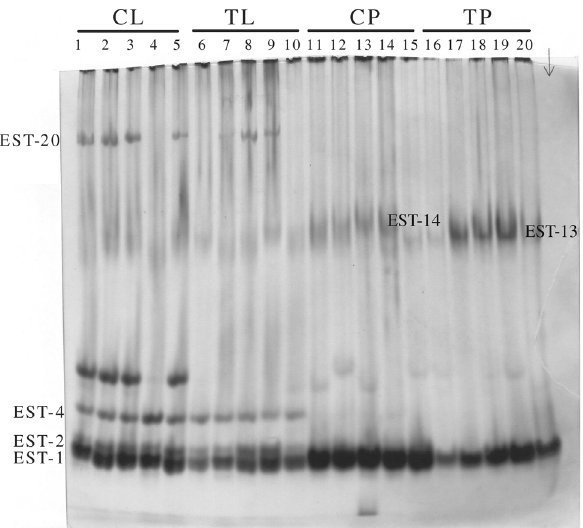
Figure 1 - A polyacrylamide gel showing esterase bands that presented changes in expression, in Aedes aegypti larvae and pupae submitted to continuous phenobarbital (PB) treatment and control. The results of five individuals per experiment are shown. CL = control larvae; TL = treated larvae; CP = control pupae; TP = treated